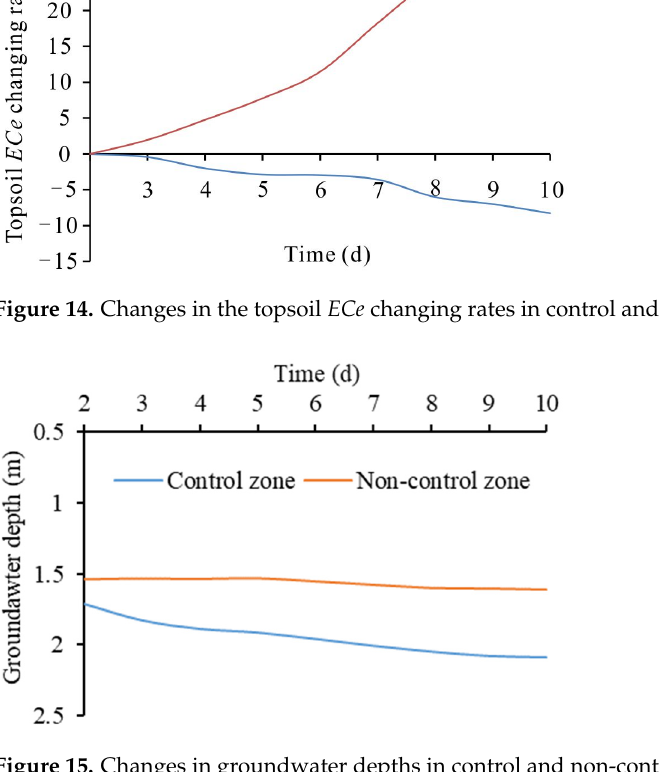
Figure 15. Changes in groundwater depths in control and non-control zones.